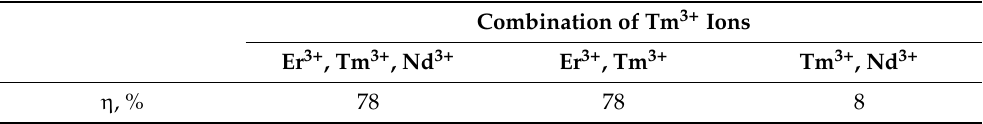
Table 3. Values of energy transfer efficiency for the one-, two-, and triple-doped systems with the selective excitation of Tm 3+ ions.